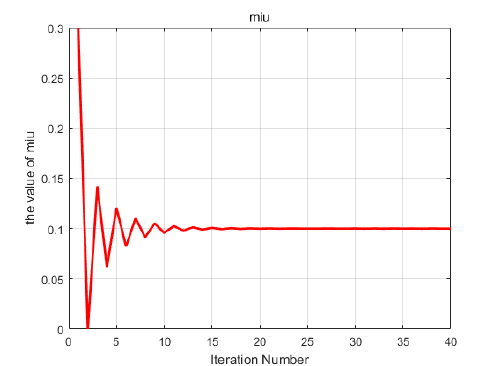
Figure 13. The variation trend of value of µ of SPGD.